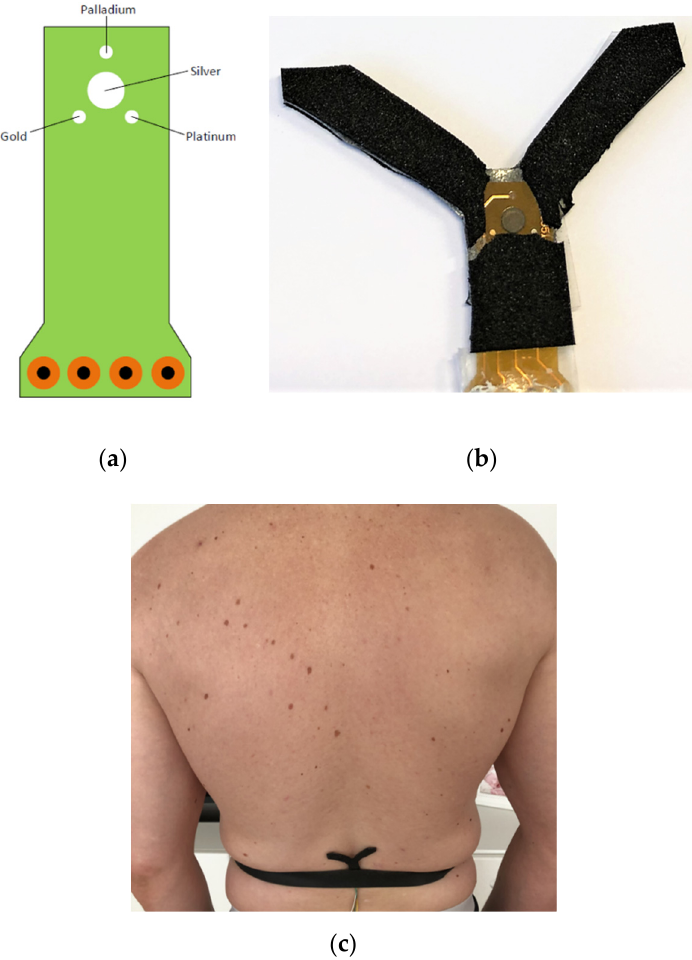
Figure 5. ( a ) Sketch showing the general design of the flexible circuit board. ( b ) Photograph of a wearable e-tongue prototype. ( c ) Wearable e-tongue attached to volunteers back, worn during ex- ercise and used for on-body analysis of the subject’s sweat. exercise and used for on-body analysis of the subject’s